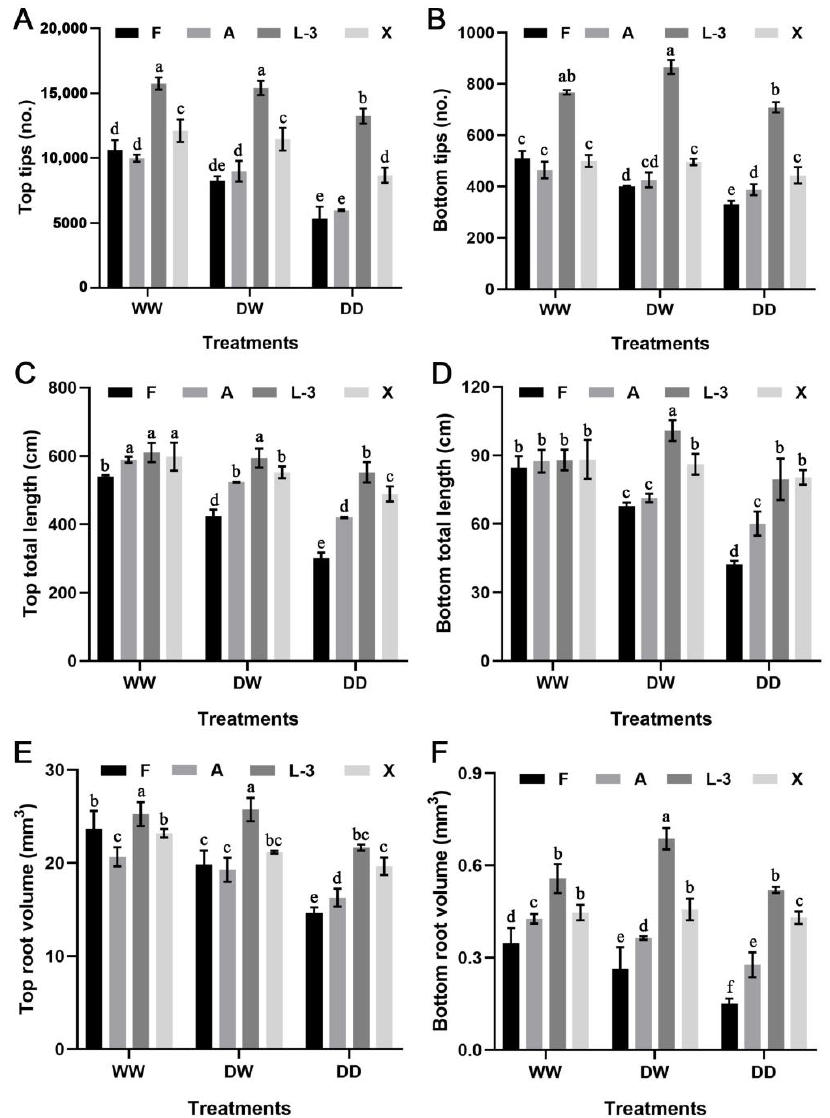
Figure 7. Phenotypic indexes of roots of four potato cultivars under different conditions. ( A ), the number of roots in top pots. ( B ), the number of roots in bottom pots. ( C ), the total length of